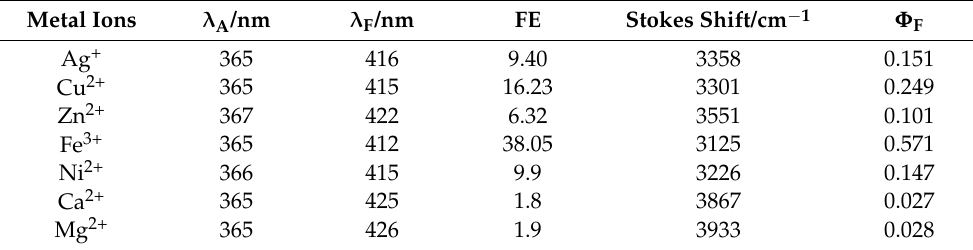
Table 3. Photophysical characteristics of NI1 in DMF solution and presence of metal cations.